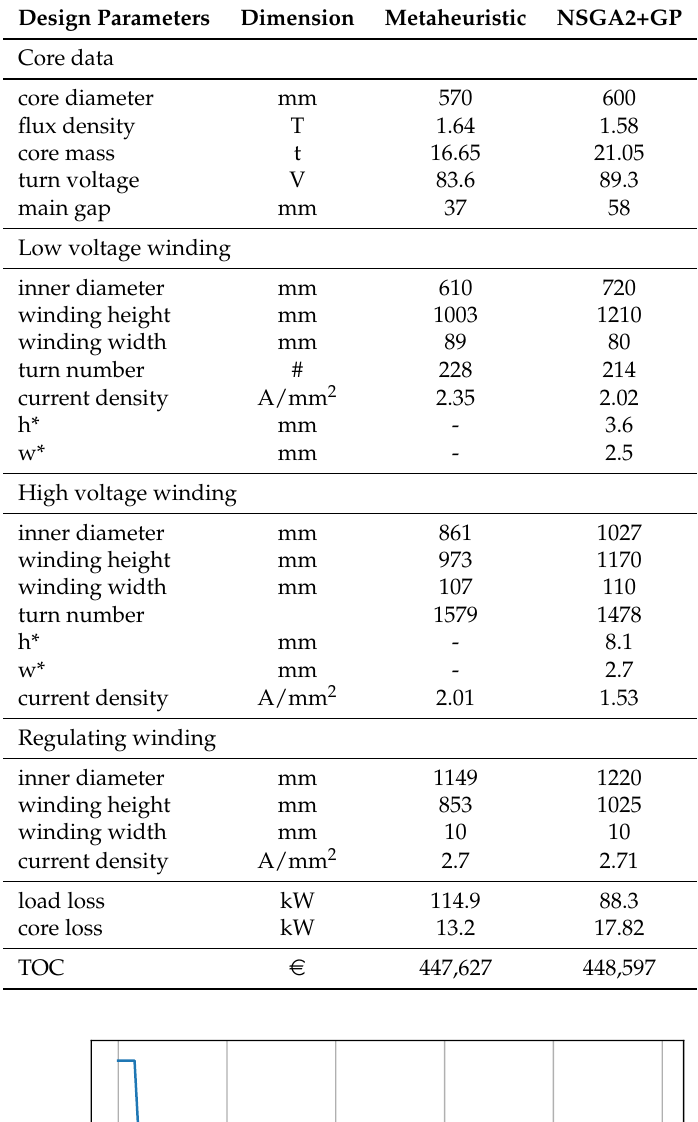
Table 5. List of the optimization model results.